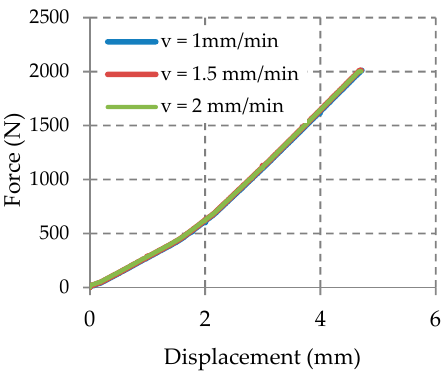
Figure 21. Force-displacement graph obtained on composite plate at different speeds loading.